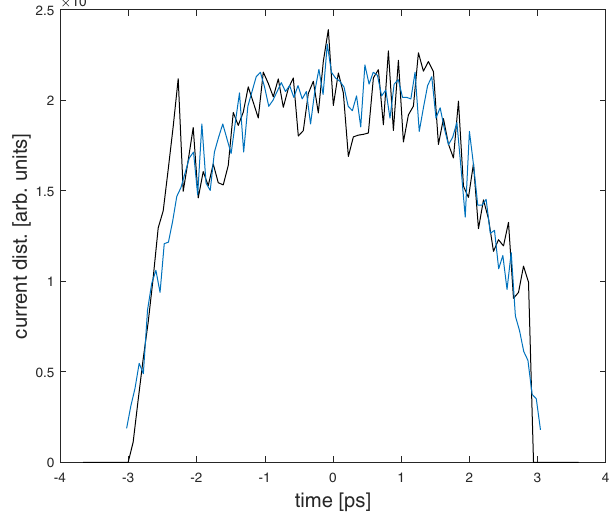
FIG. 6. Simulation results of the current distributions for a cigar (fat) beam. The blue line represents the input current distribution at the dechirper and the black line the reconstructed current